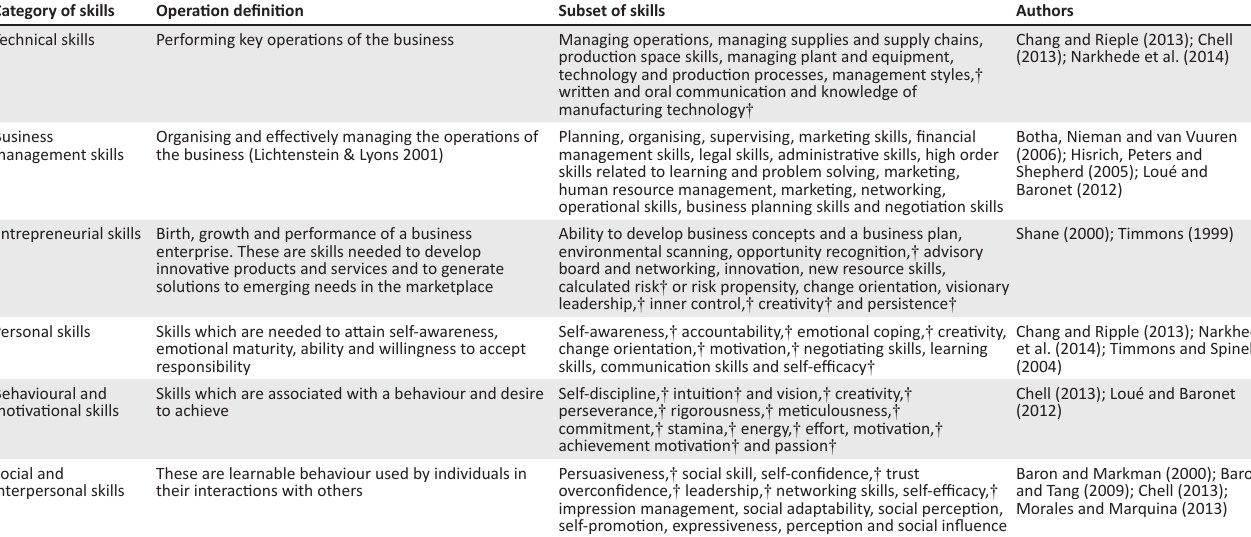
TABLE 2: Skills categories and their